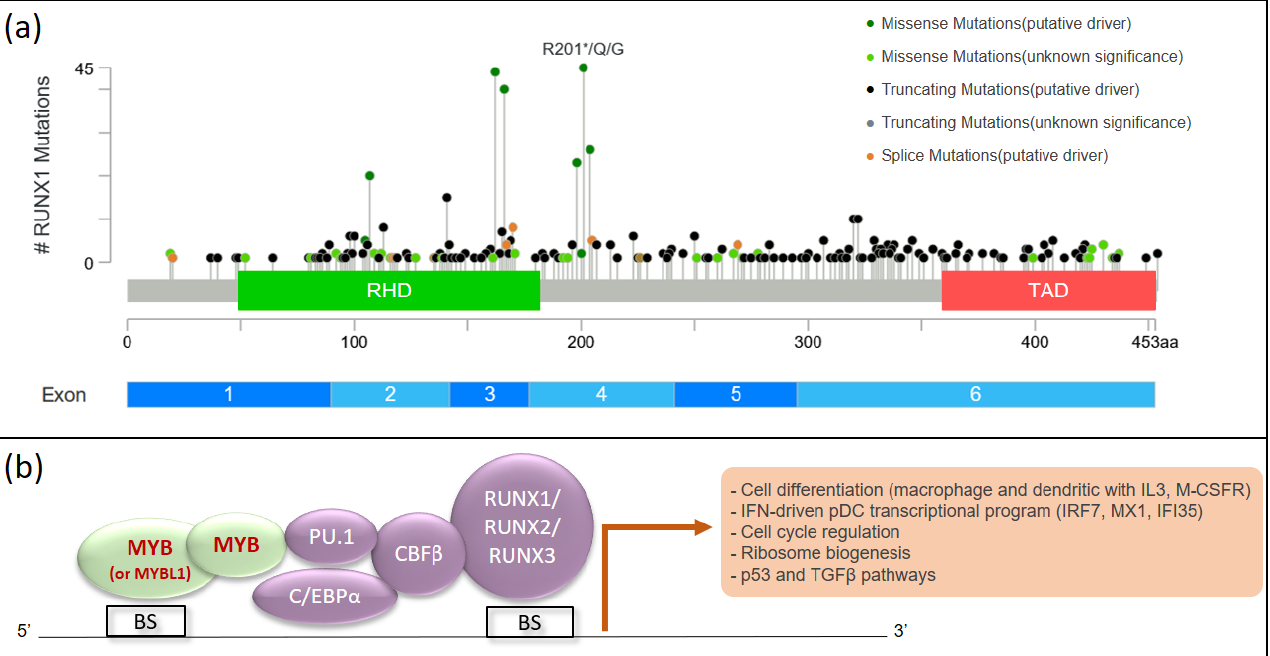
Figure 3. Mutation distribution and interaction network for RUNX1 and its transcriptional targets. ( a ) Mutation distribution for RUNX1 along the gene in AML ( n = 378 mutations, 288 patients). Adapted from www.cbioportal.org data base. RHD, runt homology domain responsible for DNA- binding and interaction with a common heterodimeric partner, CBFb; TAD, c-terminal transactivation domain. ( b ) RUNX1 interaction network: RUNX1 interacts with its binding partner CBFB, in a complex including CEBP α , PU.1, and MYB. The targeted genes are involved in cell differentiation, interferon-driven pDC transcriptional program, cell cycle regulation, ribosome biogenesis, and p53/TGF β pathways. BS, Binding Site for RUNX family or MYB.